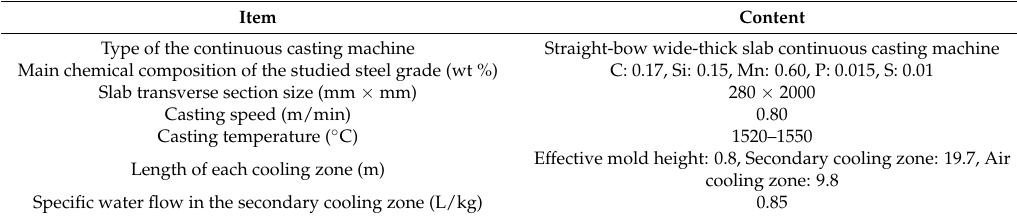
Figure 1. Schematic of the two-dimensional (2D) heat transfer model. Table 1. The practical production conditions for the wide-thick slab continuous